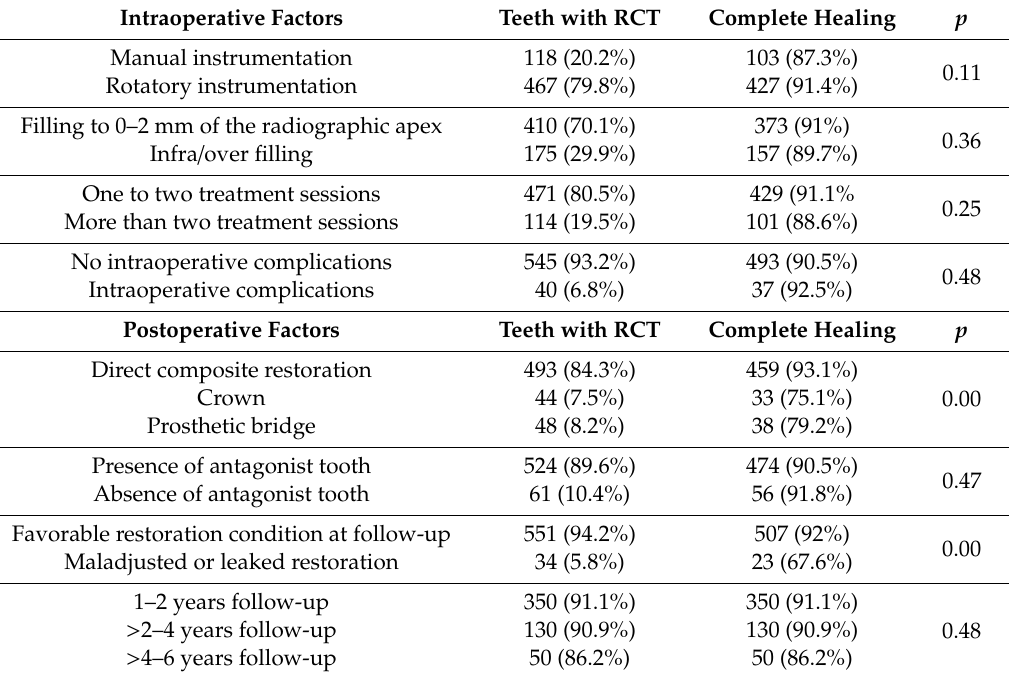
Table 2. Registered intraoperative and postoperative